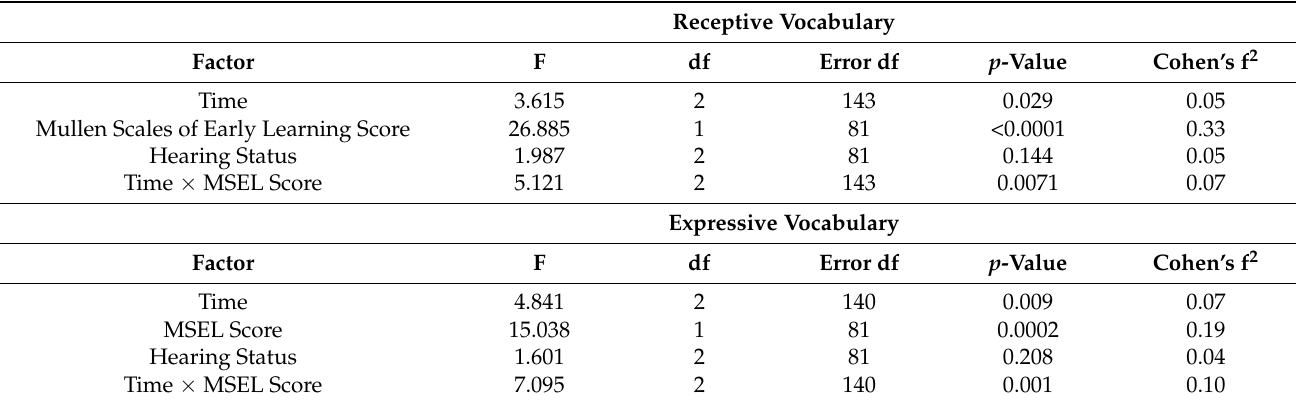
Table 7. Results of the Analysis of Variance predicting MacArthur-Bates Communicative Develop- ment Inventories (percentile).